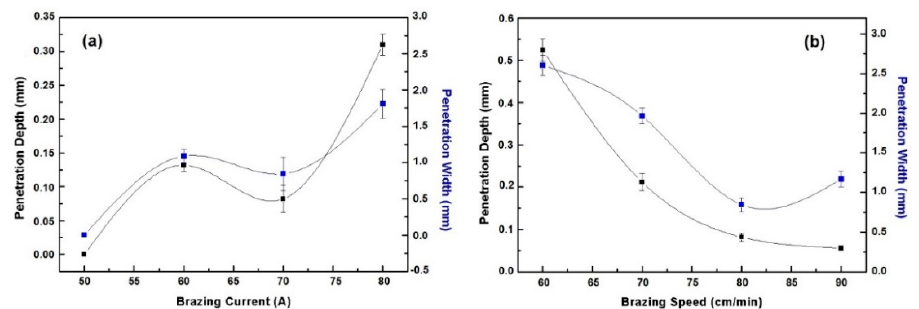
Figure 7. The variation of penetration depth and width with ( a ) arc current (at 80 cm/min) and ( b ) speed (at 70 A).